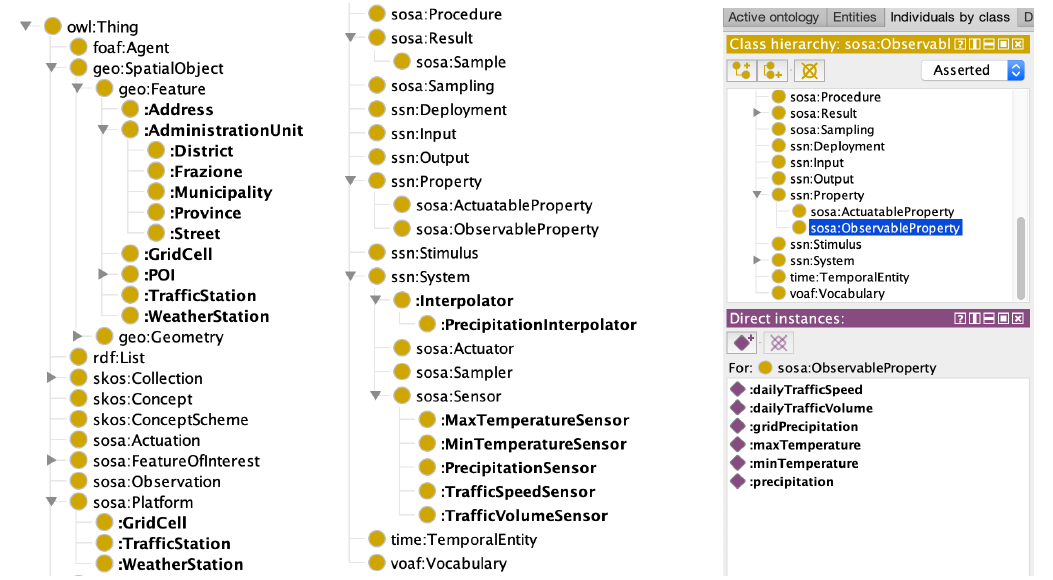
Figure 4. A fragment of the